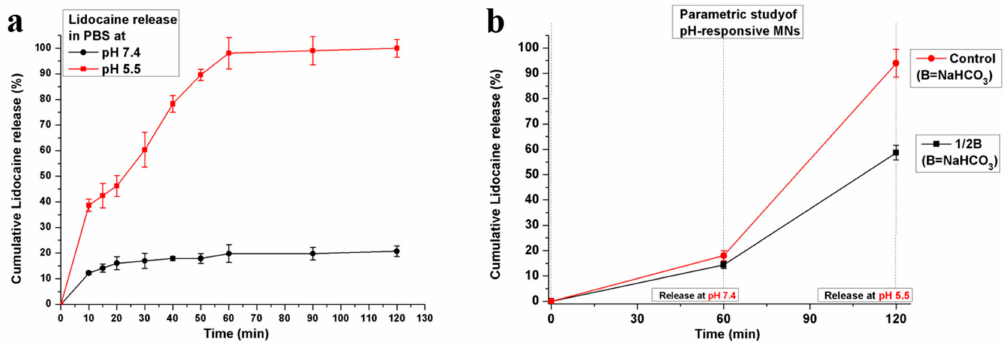
Figure 3. ( a ) Release profile of lidocaine for pH-responsive porous polymer-coated MNs incubated a mildly acidic environment (pH 5.5) at 37 ◦ C; ( b ) release rate (line slope) of lidocaine as a function of NaHCO 3 concentration in the release media for control (B, L) and 1 / 2B = (1 / 2B, L), containing